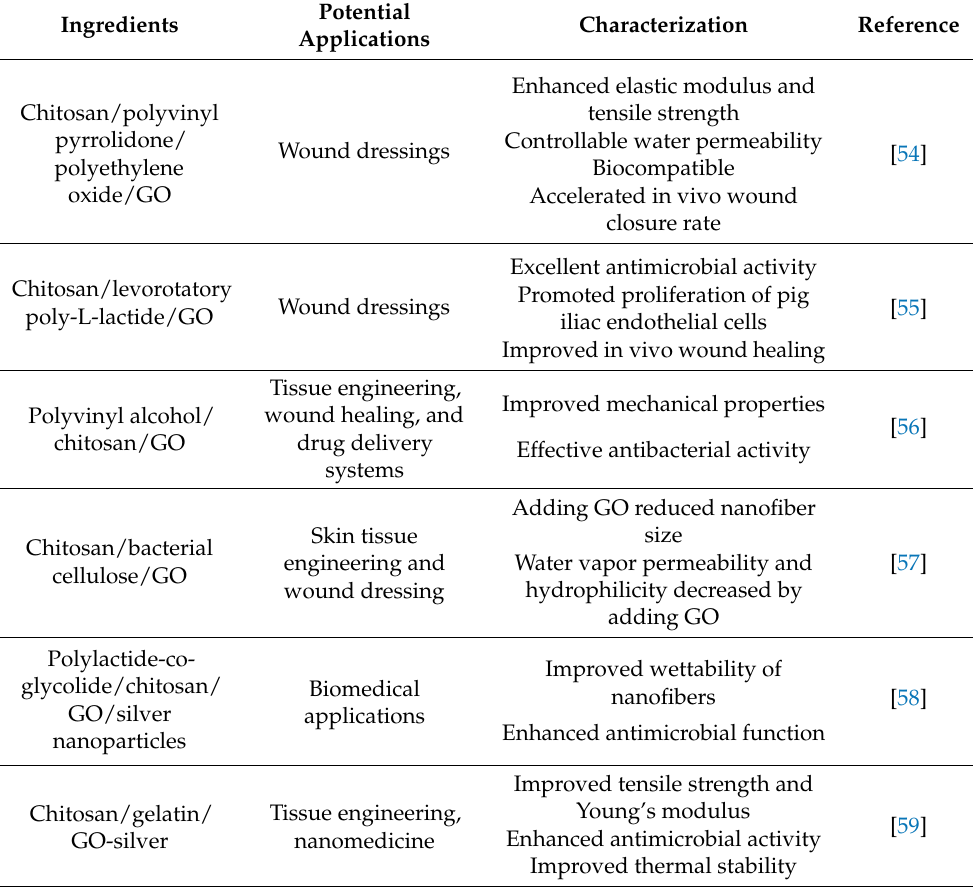
Table 2. Chitosan/GO nanofiber webs and their biomedical applications.